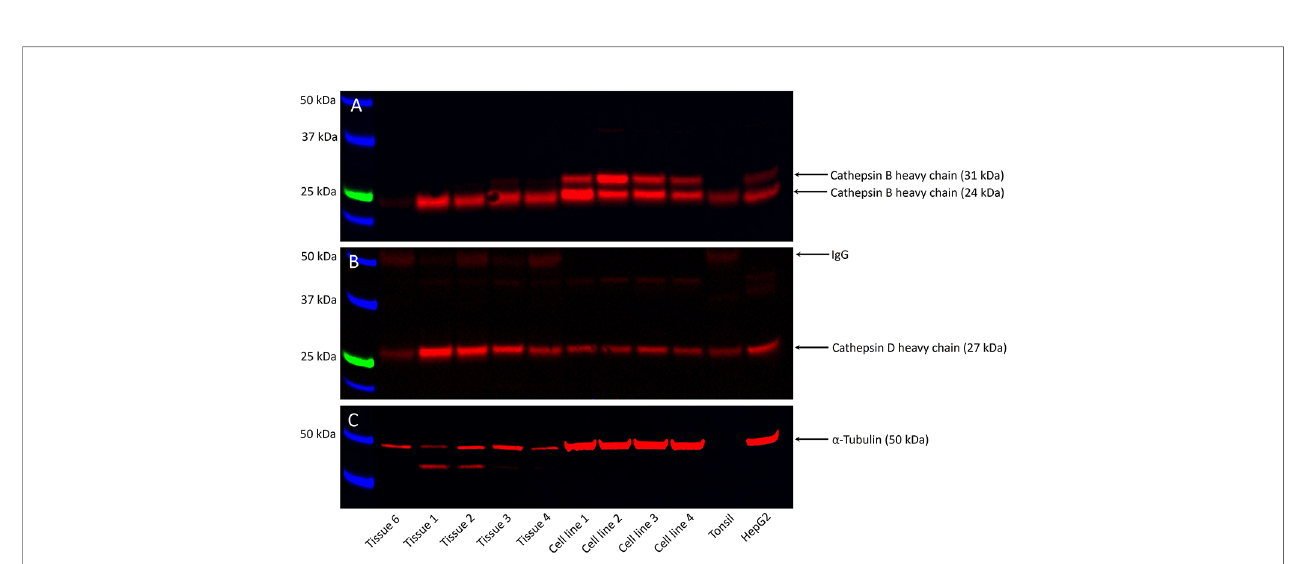
FIGURE 4 | Representative Western blot images of total protein extracted from fi ve metastatic cutaneous head and neck squamous cell carcinoma (mHNcSCC) tissue samples and four mHNcSCC-derived primary cell lines, demonstrating the presence of cathepsin B in four out of the fi ve tissue samples and all four cell lines (A) , and cathepsin D in all fi ve tissue samples and all four cell lines (B) . Relatively equal amounts of proteins were loaded into each lane, as con fi rmed by a -tubulin (C) . The molecular weight ladder (kDa) is labelled for each blot.